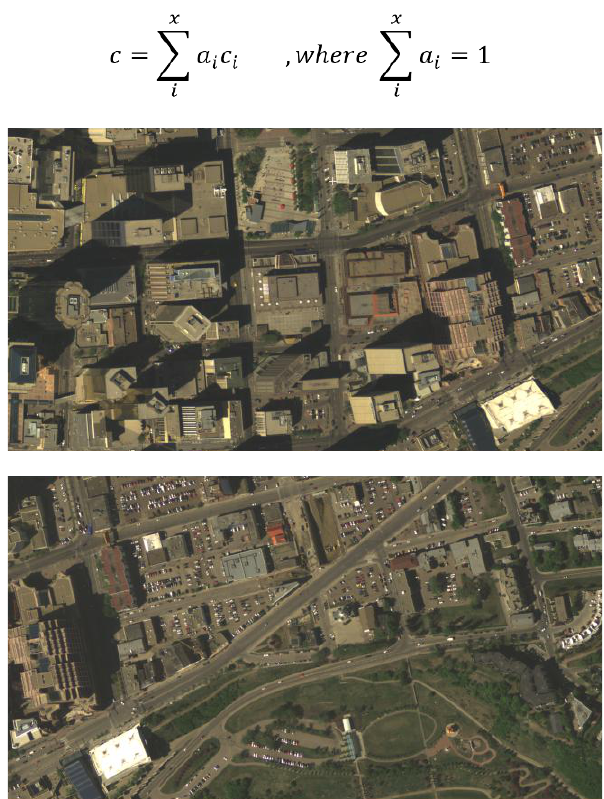
Figure 2. An example depicting two overlapping orthophotos (top image is left in the overlap and the bottom image is right)